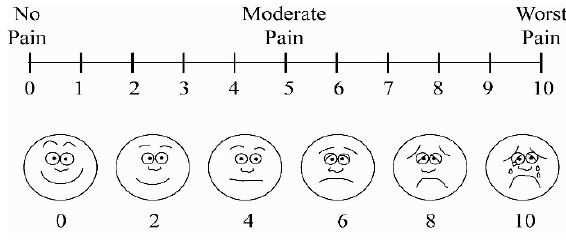
Figure A1. Visual representation of pain perception